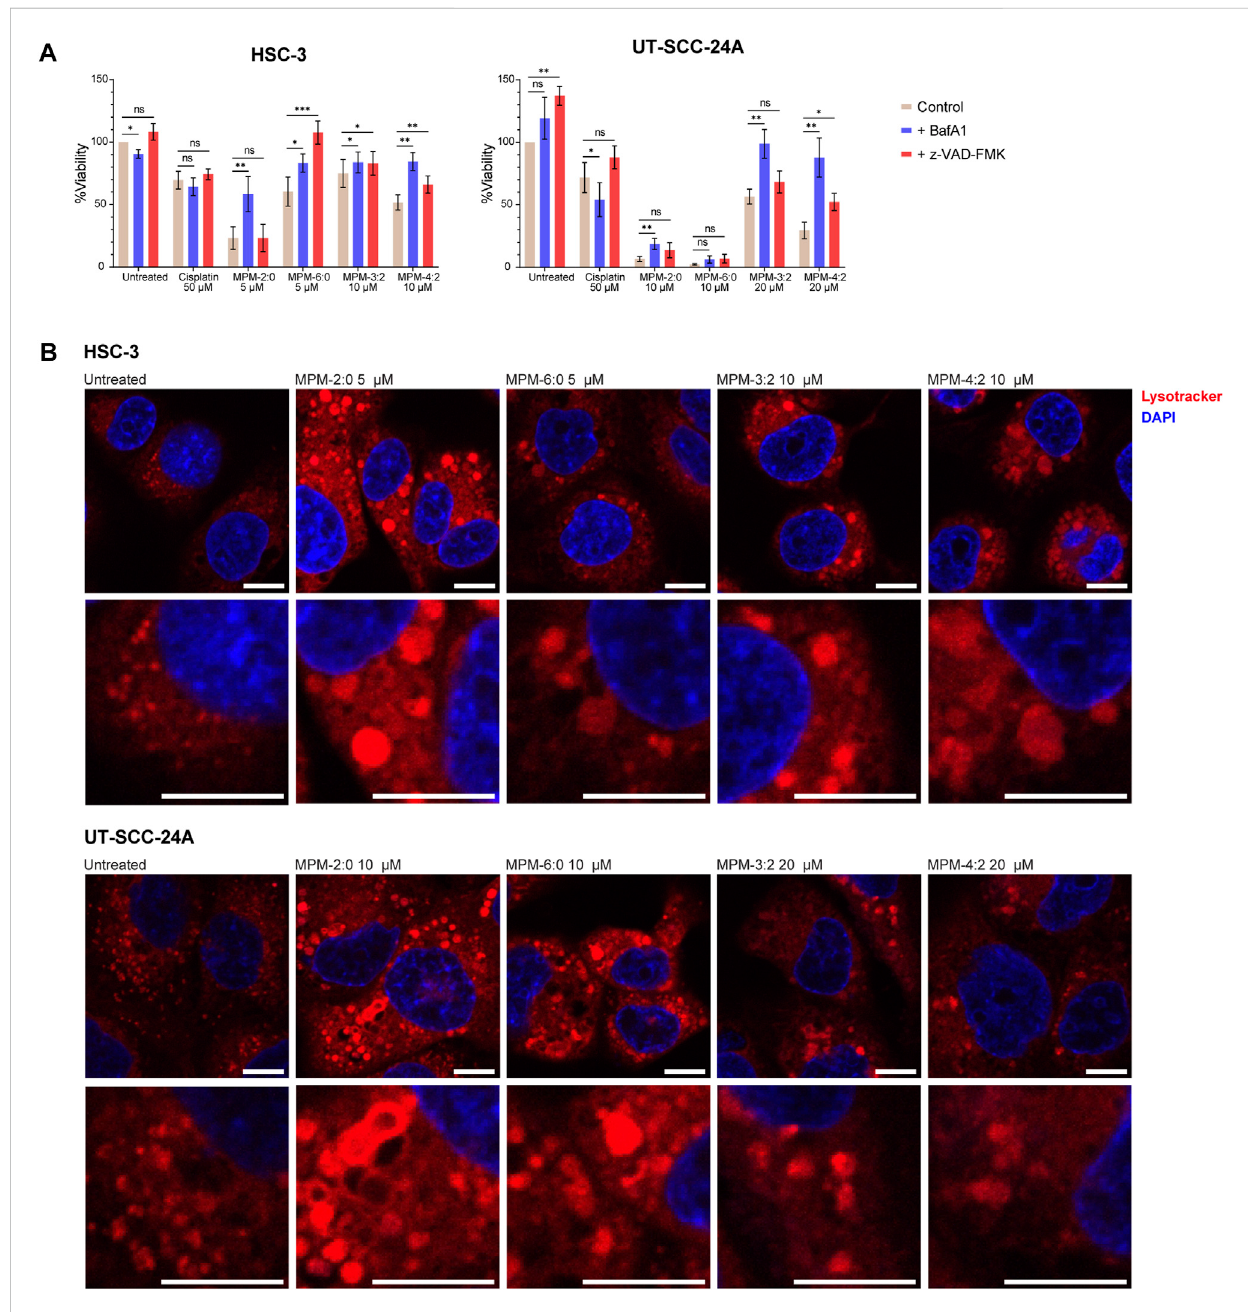
FIGURE 4 The viability of HSC-3 and UT-SCC-24A cells treated with MPMs in the presence of ba fi lomycin A1 (BafA1) or the pan caspase inhibitor Z-VAD-FMK wasdeterminedbymeansoftheMTSassay (A) .Thegraphshowsthemeanfromthreeindependentexperiments.Signi fi cantdifferencesweredetermined by paired t-tests. (B) HSC-3 and UT-SCC-24A cells were left untreated or were treated with the MPMs for 24 h before being stained with Lysotracker Deep Red and imaged by confocal microscopy. All scale bars are 10